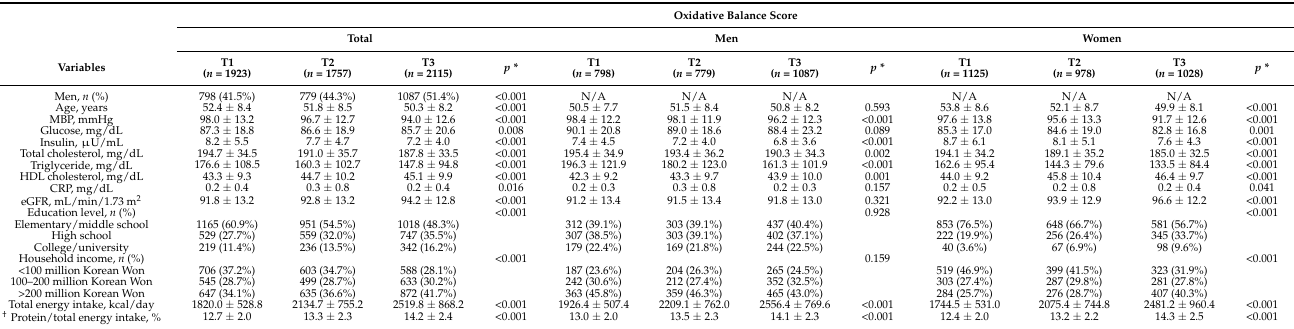
Table 2. Baseline characteristics of the study population.